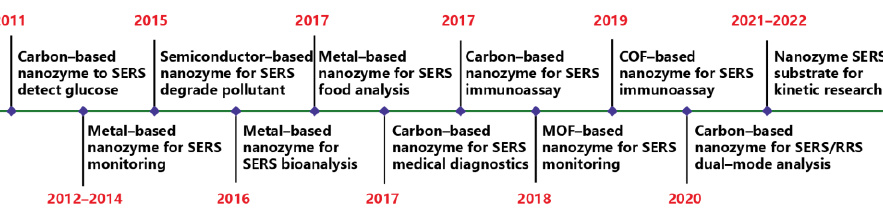
Figure 1. ( a ) Top-down synthesis and ( b ) bottom-up synthesis of nanozymes in SERS.